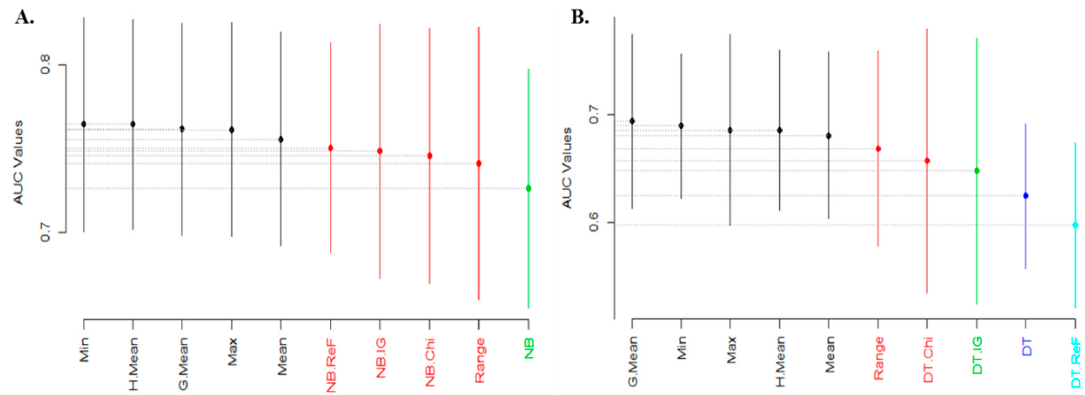
Figure 6. Scott-Knott Rank Test Result of FS methods on NB and DT classifier models based on average AUC values. ( A ) Average AUC values of NB; ( B ) Average AUC values of DT.